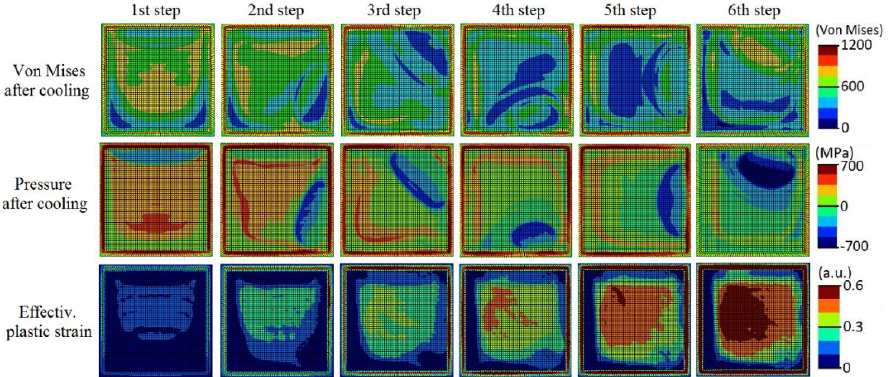
Figure 8. Computed residual von Mises stress, pressure, and effective plastic strain contours of the substrate surface at the end of the cooling stage of each layer step of the SLMed NIST part.